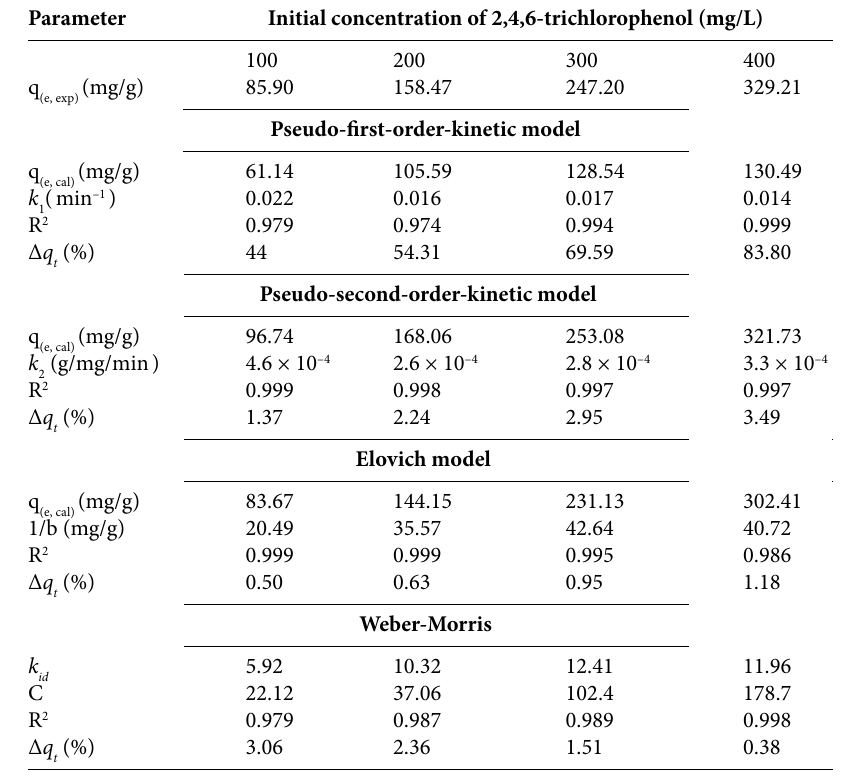
Table 2. Kinetic parameters biosorption of 2,4,6-TCP on PBP